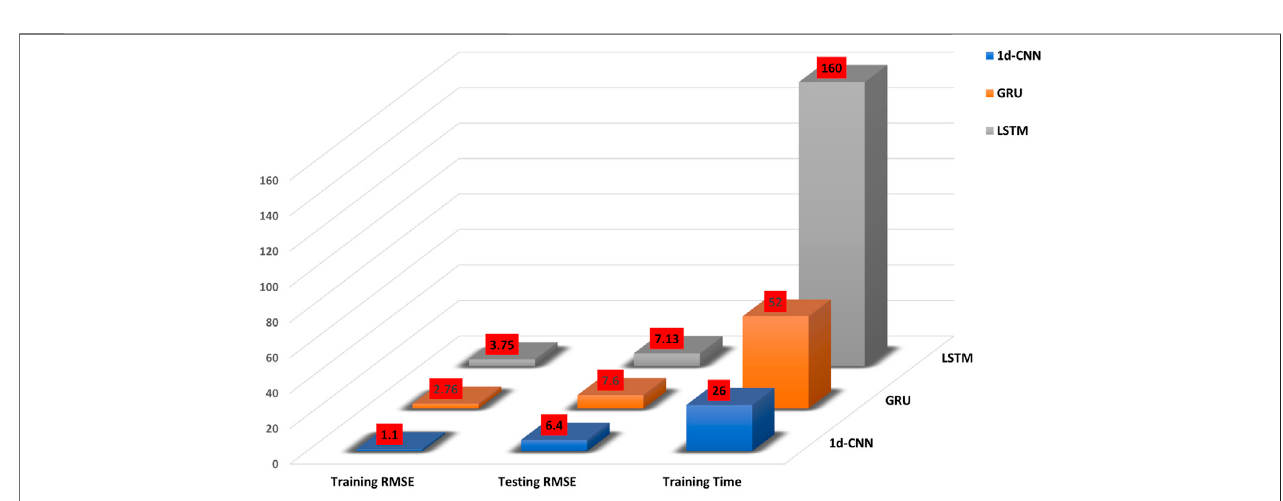
FIGURE 11 | Training RMSE, testing RMSE, and training time performance metrics of LSTM, GRU, and 1D-CNN at optimal hyperparameter value.